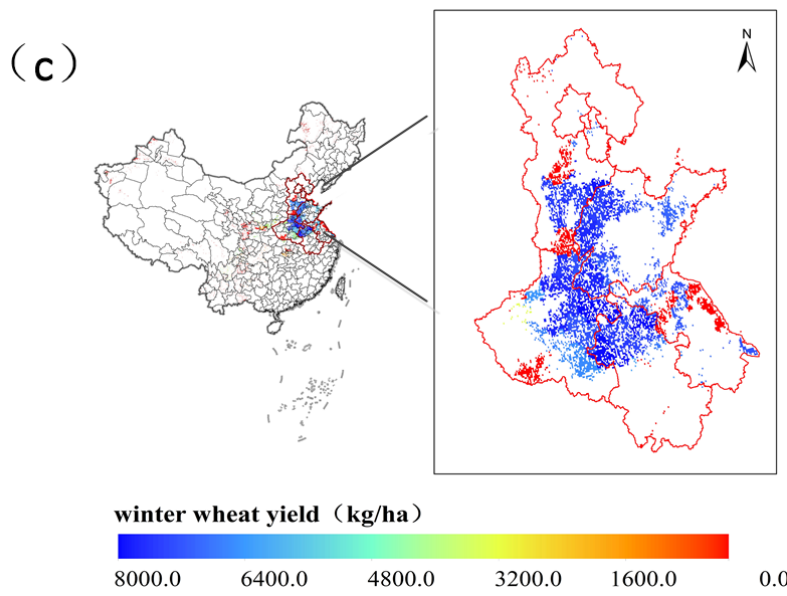
Figure 5. Spatial pattern of winter wheat yield forecast in 2014: ( a ) RF, ( b ) MLR, ( c ) actual yield